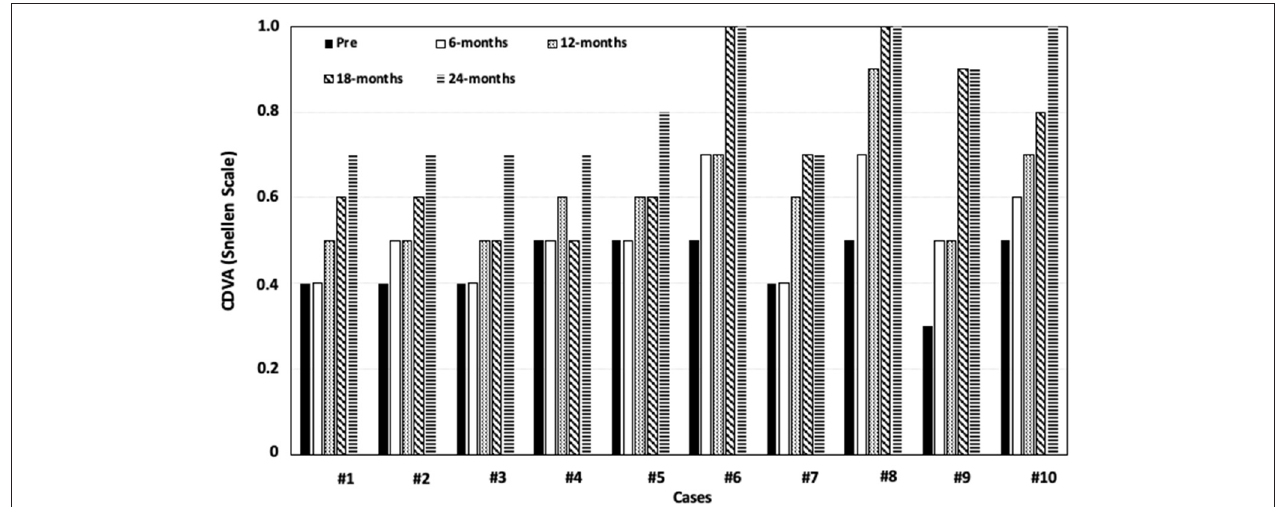
FIGURE 3 | Variation in corrected distance visual acuity (CDVA) over the whole follow-up for each